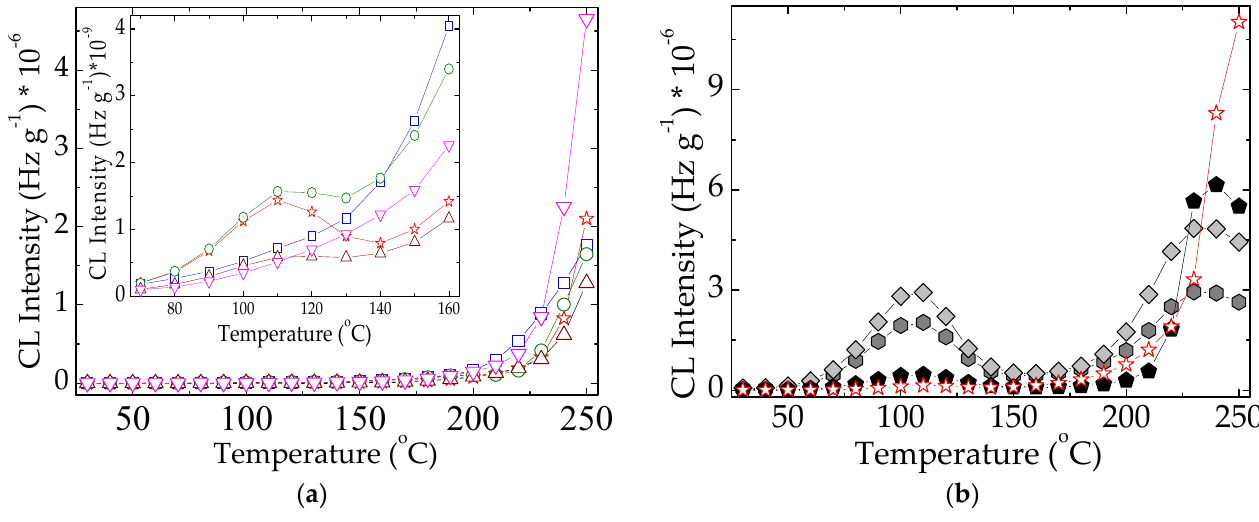
Figure 6. Non-isothermal CL spectra belonging to various compositions of EPDM samples. ( a ) red star: EPDM; blue square: EPDM/rosemary; olive cercle: EPDM/POSS 1 phr; wine triangle: EPDM/POSS 3 phr; magenta reverse triangle: EPDM/POSS 5 phr. ( b ) red star: EPDM; light grey rhomb: EPDM/capsaicin; dark grey hexagon: EPDM/quercetin; black pentagon: EPDM/oleanolic acid. Irradiation dose: 0 kGy. Heating rate: 10 °C min − 1 .